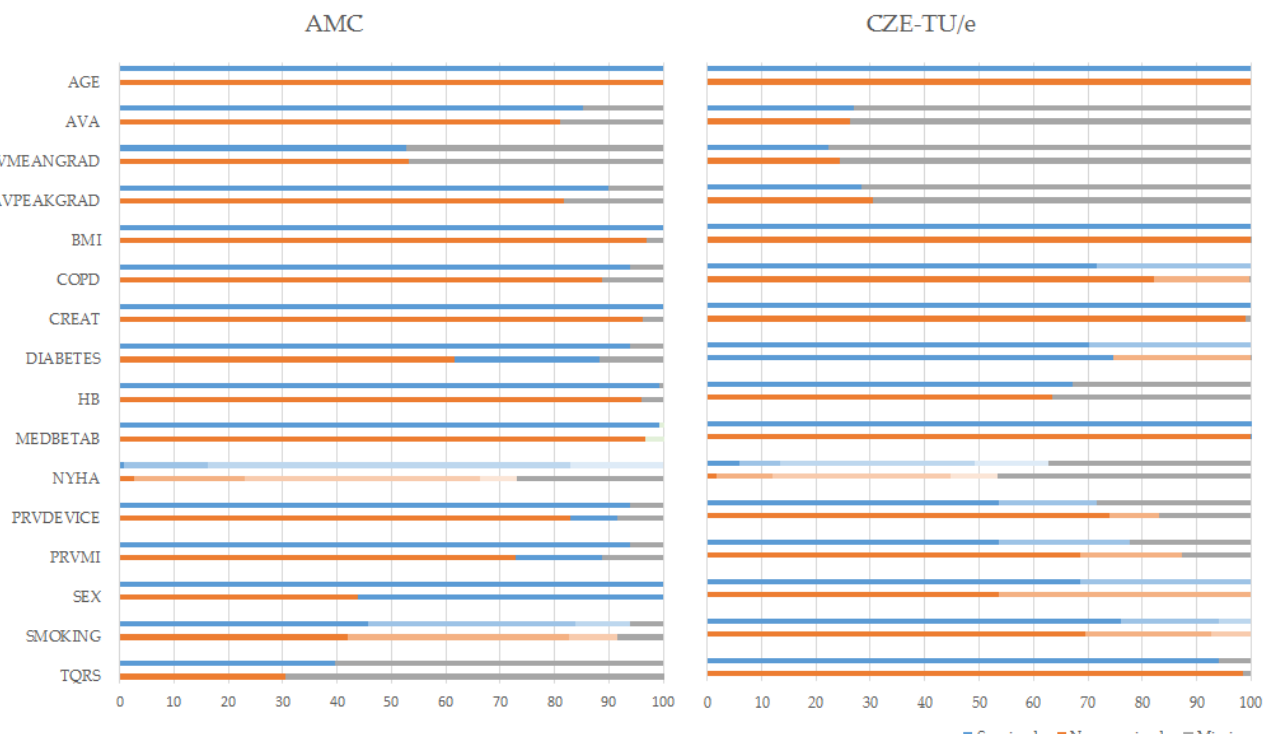
Figure A1. Distribution of missing values per patient on each center population.